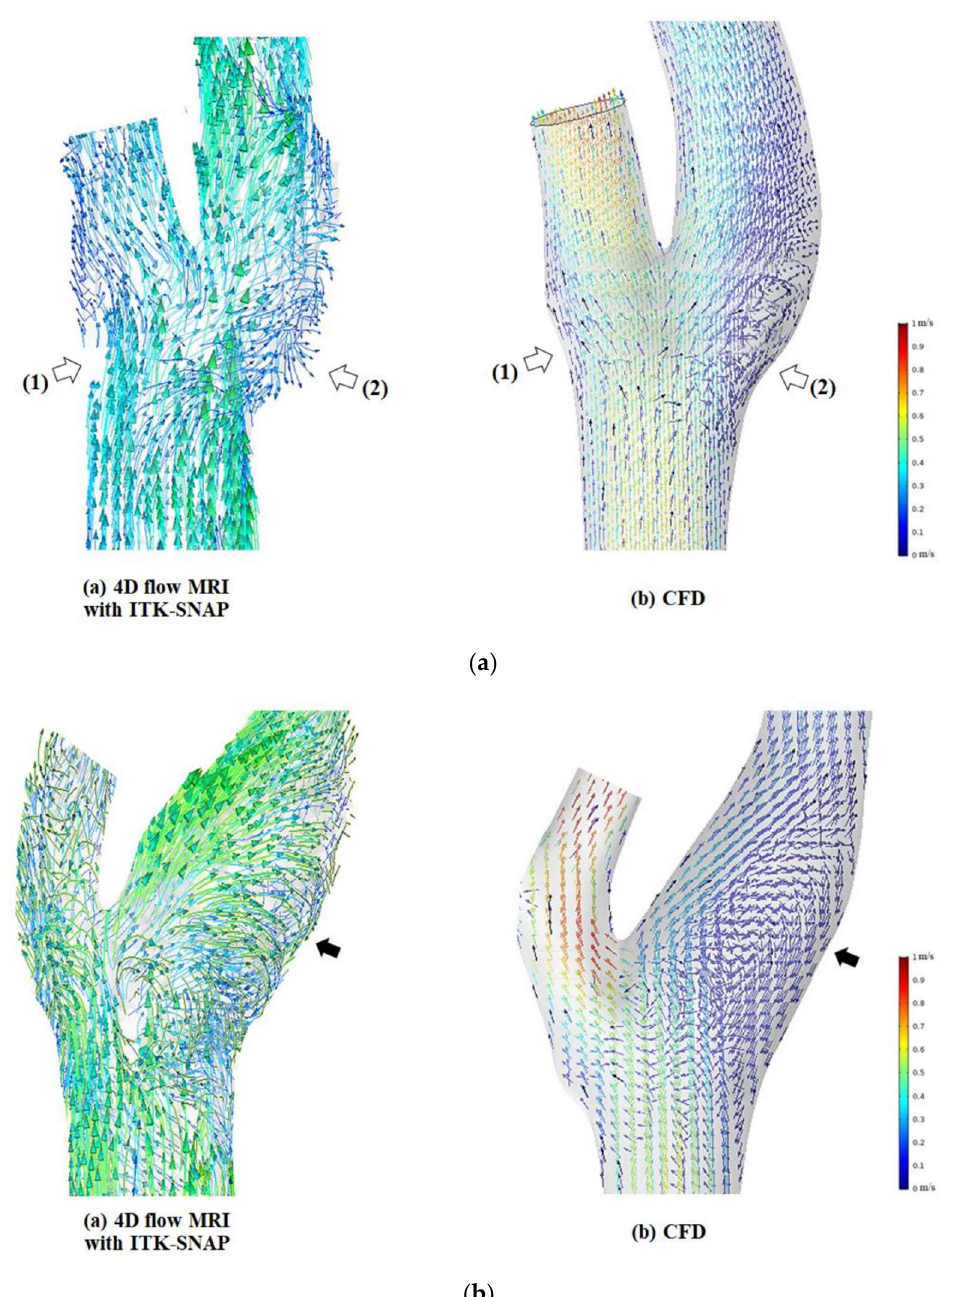
Figure 7. ( a ) The 3D vector fields derived from 4D flow MRI with ITK-SNAP ( left ) and CFD ( right ). Several streamlines were disconnected at the segment of an arterial wall within the carotid bifurcation domain in 4D flow MRI (white arrows labeled 1). Disagreement in secondary flow directions at the peripheral area of recirculation regions between the two techniques (white arrows labeled 2). ( b ) The 3D vector fields derived from 4D flow MRI with ITK-SNAP ( left ) and CFD ( right ). Generally, 4D flow MR images of secondary flow directions (black arrows) have similarities with CFD simulation.